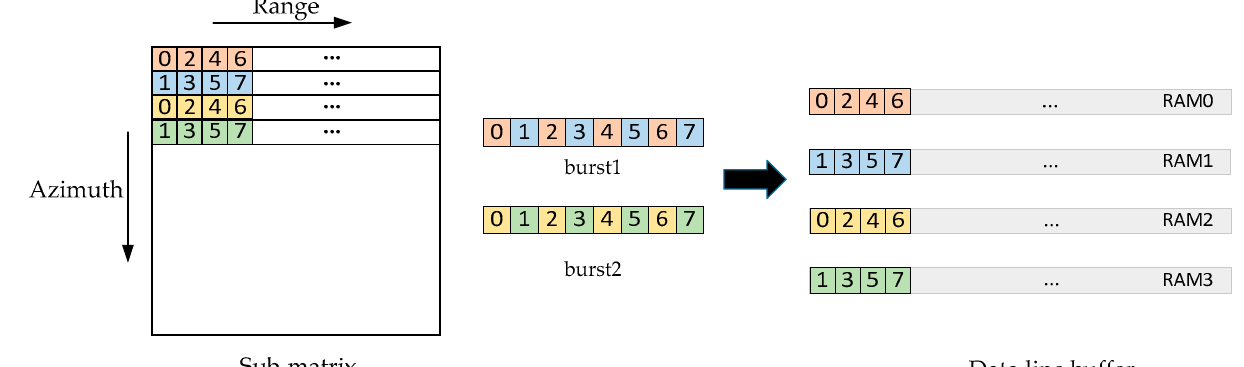
12 of 23 Figure 9. Data access address change method in range direction. ( a ) The four range lines to be accessed in the SAR data matrix; ( b ) the physical addresses of the four range lines to be accessed in DDR3 (each cell represents eight burst trans- mission data in DDR3; the red dotted line represents the data access sequence in DDR3). Since the data of two adjacent range lines are cross-stored in DDR3, among the eight data obtained by each burst transmission, two adjacent data belong to different range